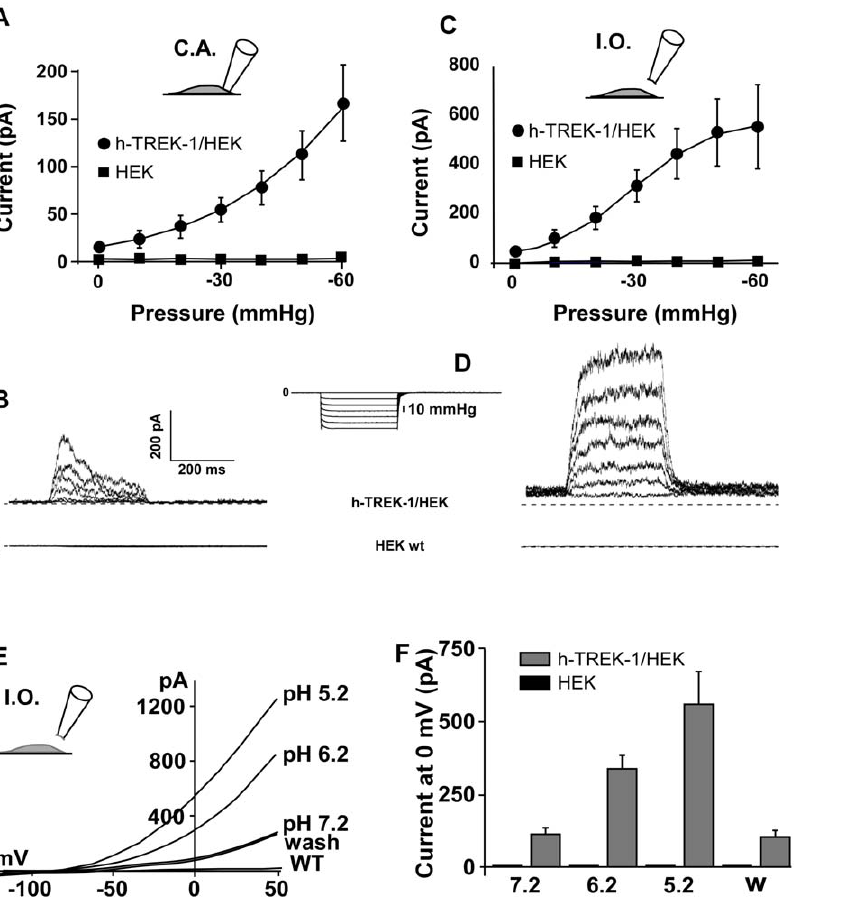
Figure 2. Stretch and pH activation of h-TREK-1 current in cell attached (C.A.) and in inside out (I.O.) patch clamp configurations. Currents were recorded by application of negative pressure and by internal acidification. A, B ) Current/pressure relationship and typical current traces obtained on h-TREK-1/HEK cells (closed circle, n=30) and on HEK cells (closed square, n=5) in cell-attached patch clamp configuration. C, D ) Current/pressure relationship and typical current traces obtained on h-TREK-1/HEK cells (closed circle, n=30) and on HEK cells (closed square, n=4) in inside-out patch clamp configuration. Inset: negative pressure step protocol, increase 2 10 mmHg. E, F ) Current/potential curves and corresponding histograms obtained after internal acidification on h-TREK-1/HEK cells (n=8) and on HEK cells